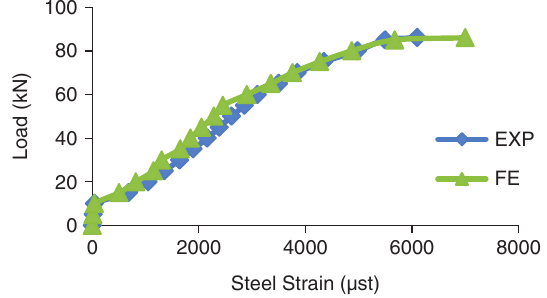
Fig. 22. Load against steel strain curves for the pre-repair phase of the beam G4R3